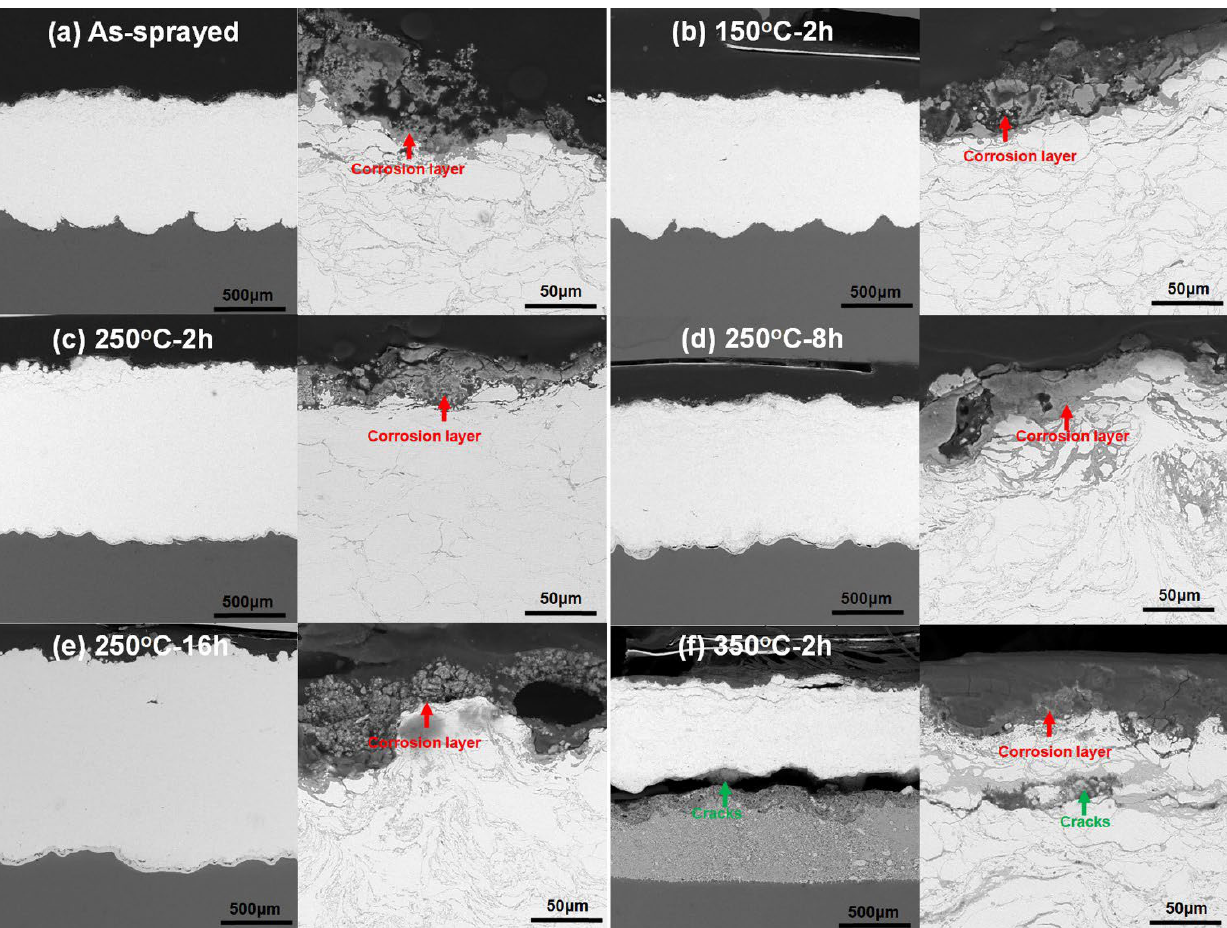
Figure 11. Cross-sectional microstructures of different Zn coatings after immersion for 14 days.